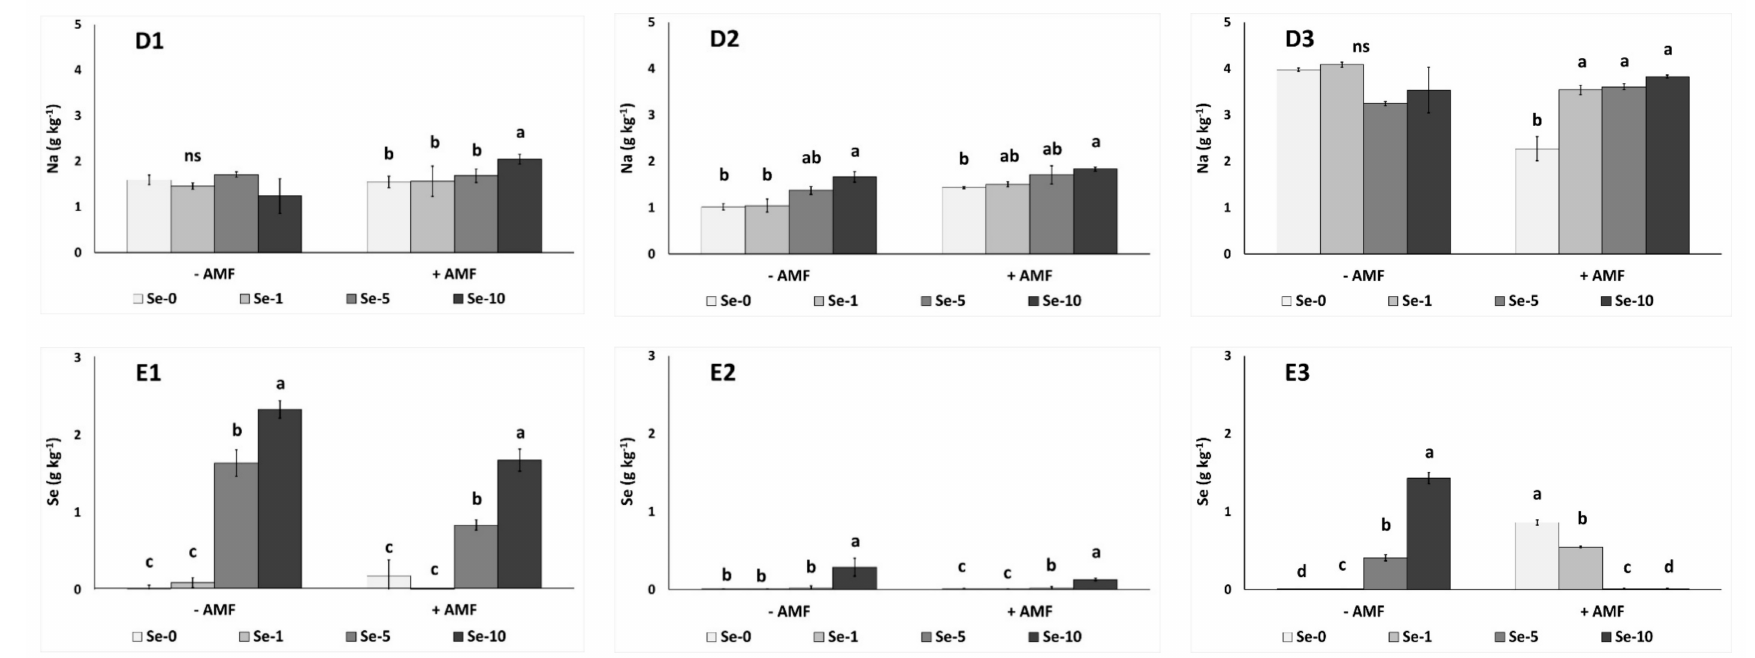
Figure 4. Effects of arbuscular mycorrhizal fungi (AMF) inoculation and selenium (Se) levels (0, 1, 5 and 10 mg L − 1 ) in the nutrient solution on nutrient content in hydroponically grown strawberries in cocosoil. ( A1 – E1 ) leaves, ( A2 – E2 ) fruits and ( A3 – E3 ) roots. Significant differences ( p < 0.05) among selenium treatments are indicated by different letters. Error bars show SE (n =